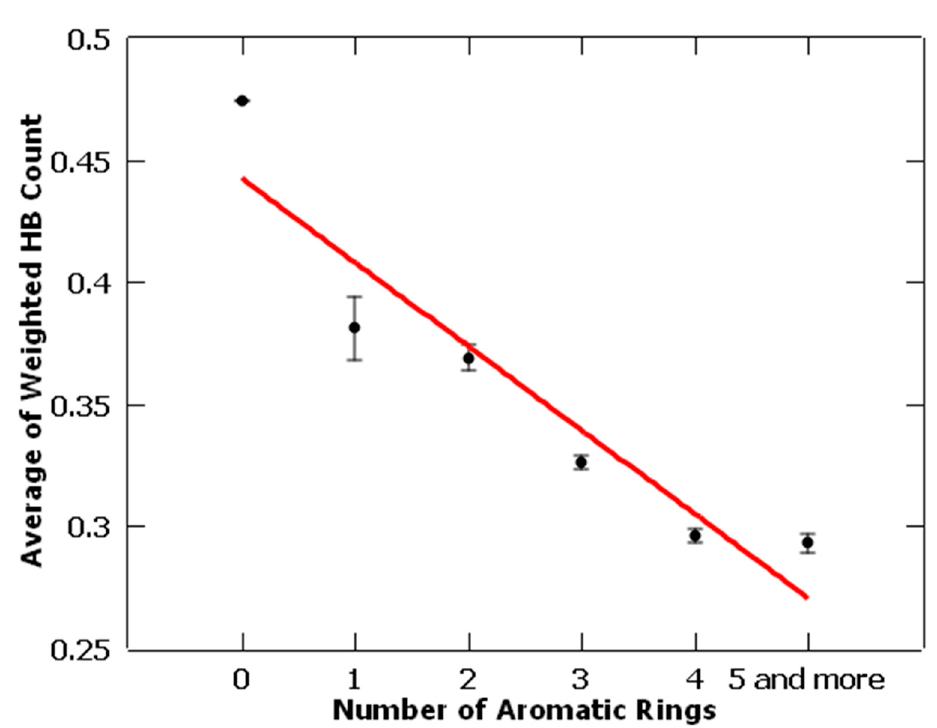
Figure 3. A plot of the average of WHBC versus number of aromatic rings.